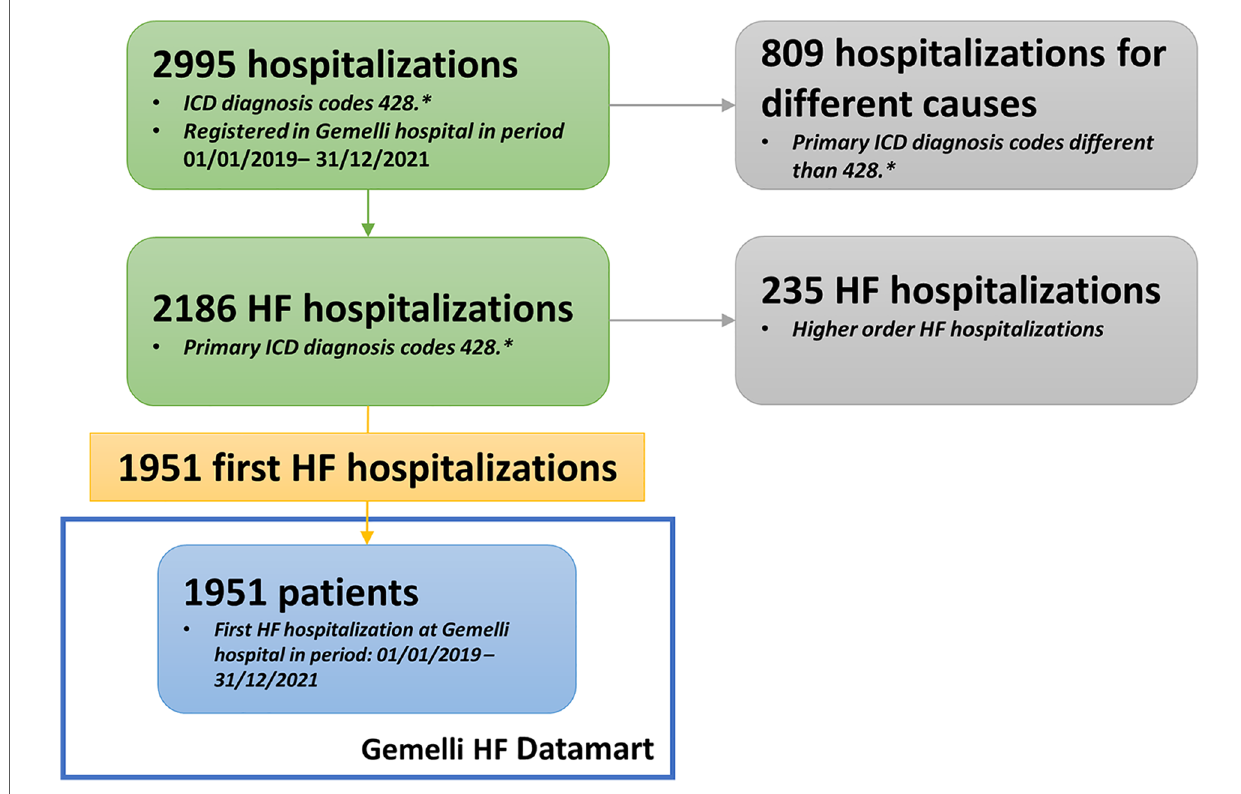
FIGURE 2 Data mart creation methodology. HF, Heart Failure; ICD, International Classi fi cation of